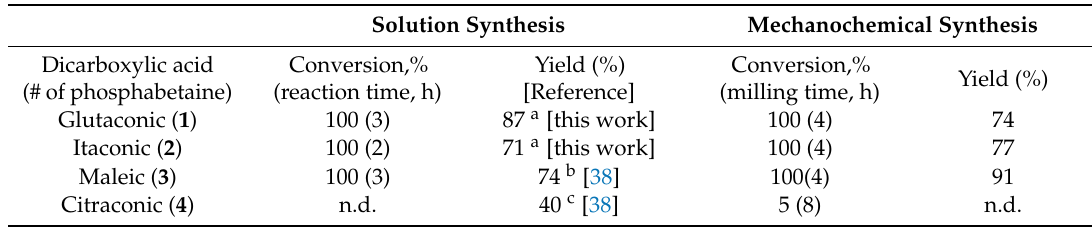
Table 1. Yields of the resulting phospabetaines in the reaction of PTA with unsaturated dicarboxylic acids in aqueous solution and in planetary ball mill Solution Synthesis Mechanochemical Synthesis Dicarboxylic